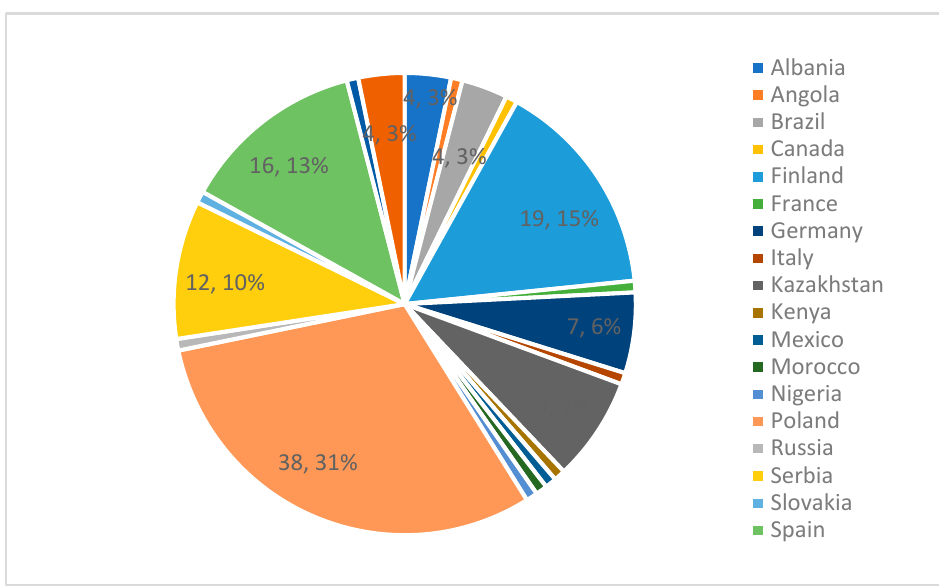
Figure 2. Distribution of non-Hungarian respondents by country.